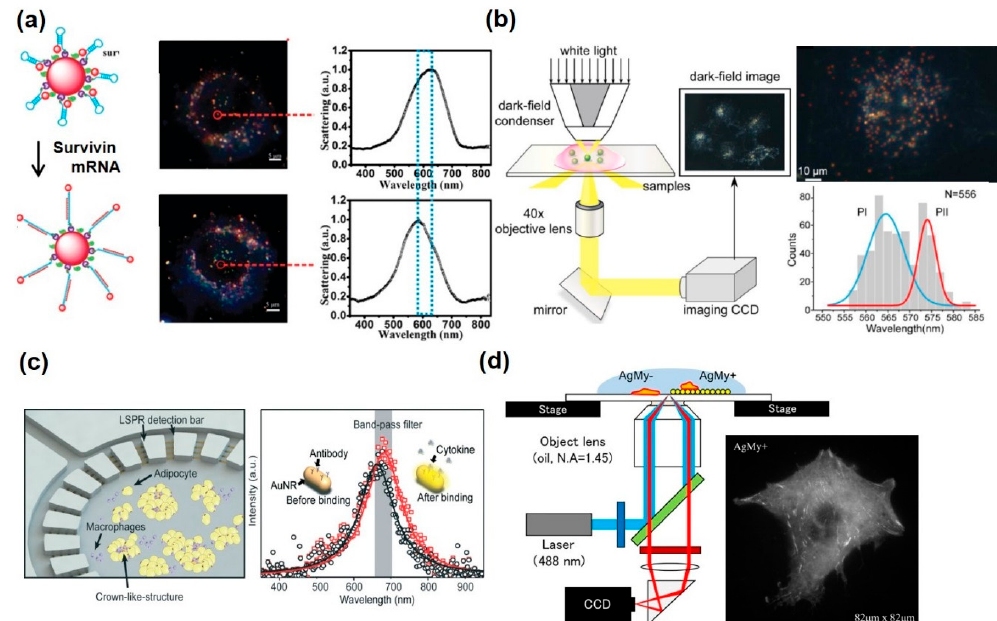
Figure 2. Localized surface plasmon resonance (LSPR)-based intracellular and extracellular analysis using metallic nanomaterials. ( a ) Survivin mRNA analysis using nanoprobes, composed of molecular beacon, small and large Au nanoparticle. Reproduced with permission [85]. Copyright 2016, Royal Society of Chemistry. ( b ) The high-throughput method for studying the resonance scattering light of single plasmonic nanoparticles in a dark-field image for intracellular analysis. Reproduced with permission [86]. Copyright 2015, Ivyspring International Publisher. ( c ) Adipose-tissue-on-chip sensing of the Au nanorod. Reproduced with permission [87]. Copyright 2018, Royal Society of